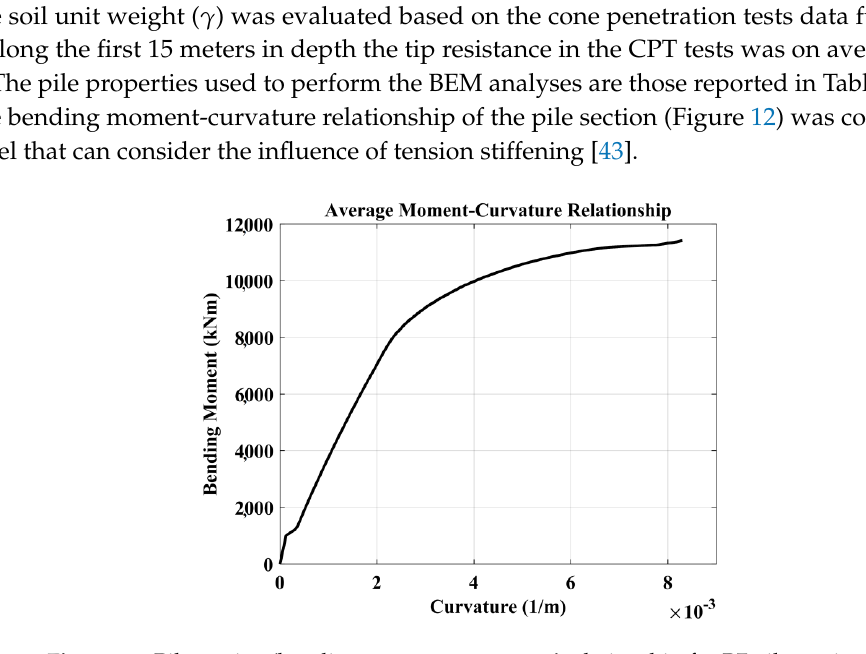
Table 3. Structural properties of bored pile.